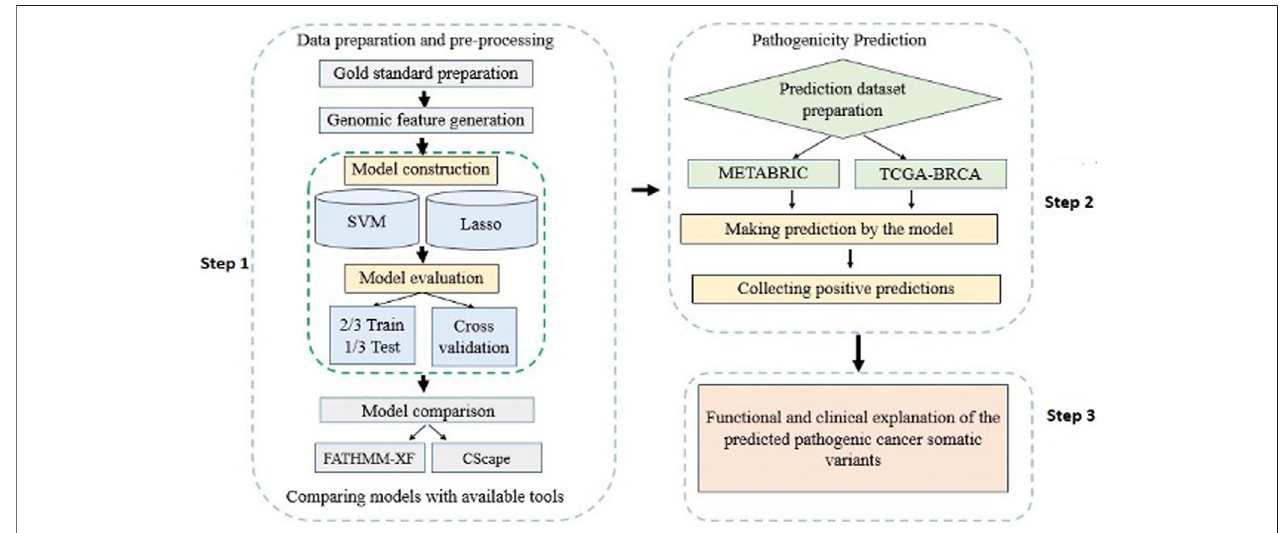
FIGURE 1 | A fl owchart overview of the steps of the study modelling and application of computational algorithms designed based on supervised classi fi cation